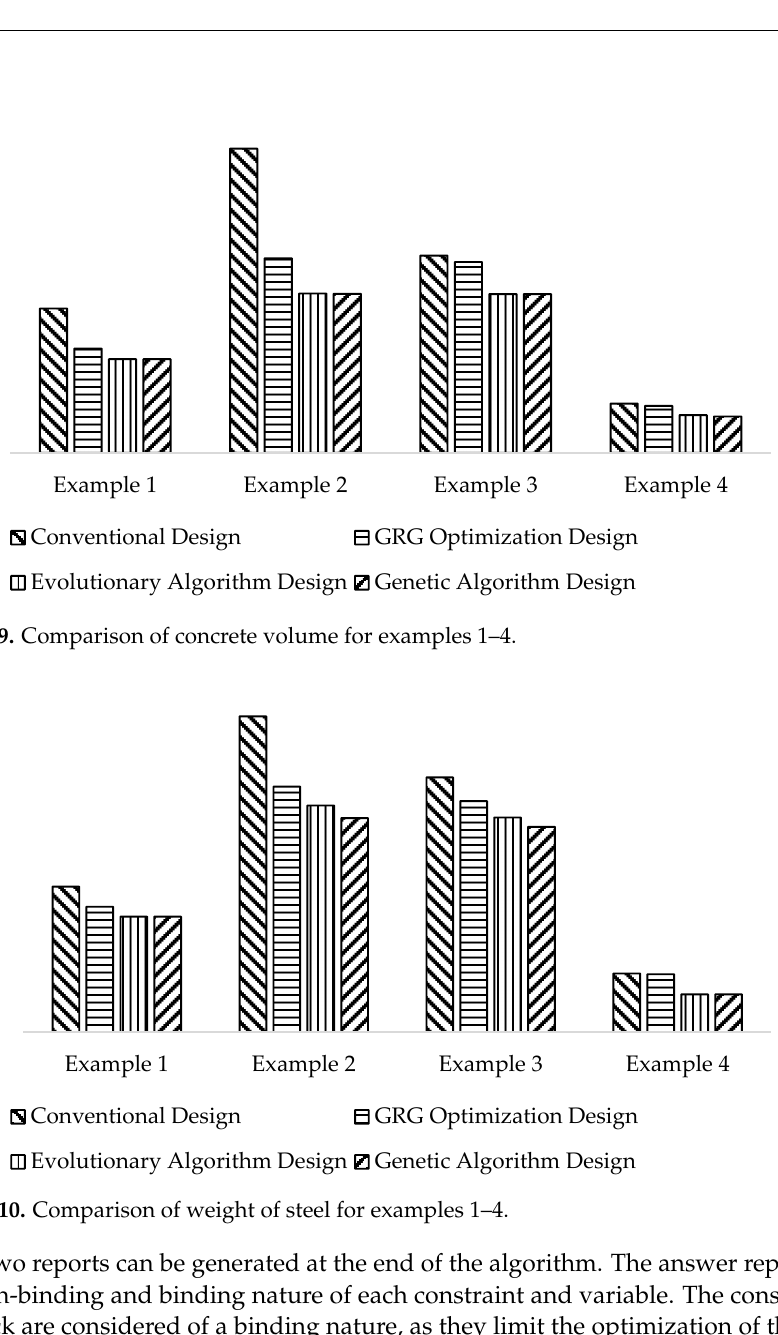
Figure 10. Comparison of weight of steel for examples 1–4.